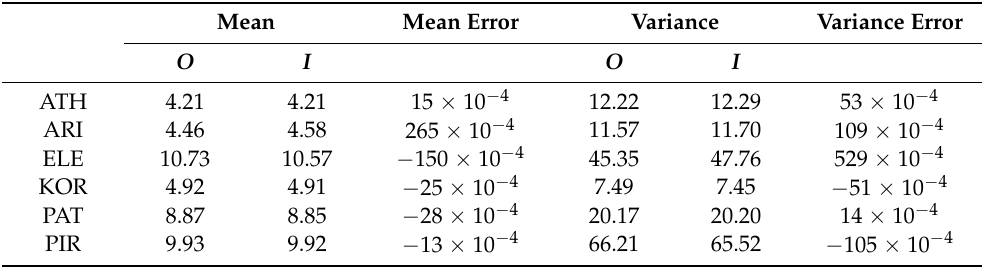
Table 9. Mean and variance values results, for the original ( O ) and the interpolated ( I ) datasets, along with the corresponding error, per monitoring station for SO 2